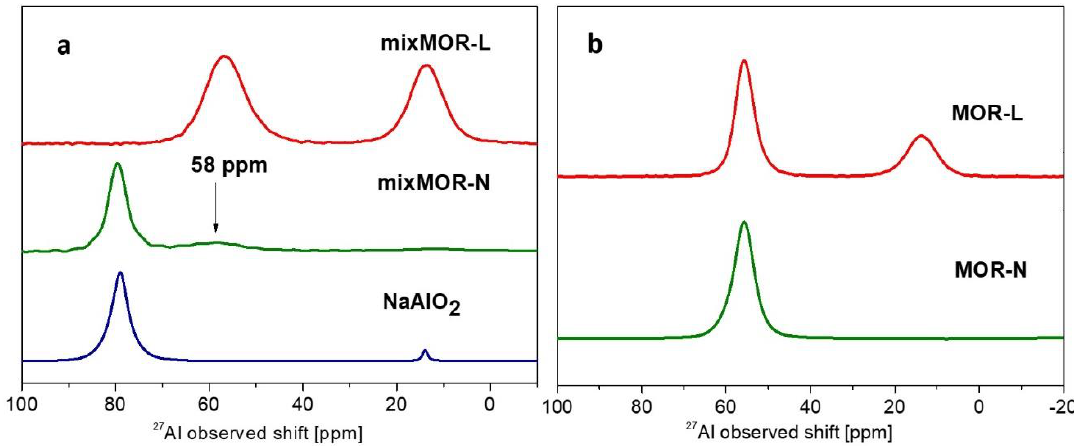
Figure 9. 27 Al MAS NMR spectra of ( a ) mixtures milled with liquid (mixMOR-L) and by neat milling (mixMOR-N) ( b ) MOR products obtained after crystallization of respective mixtures.